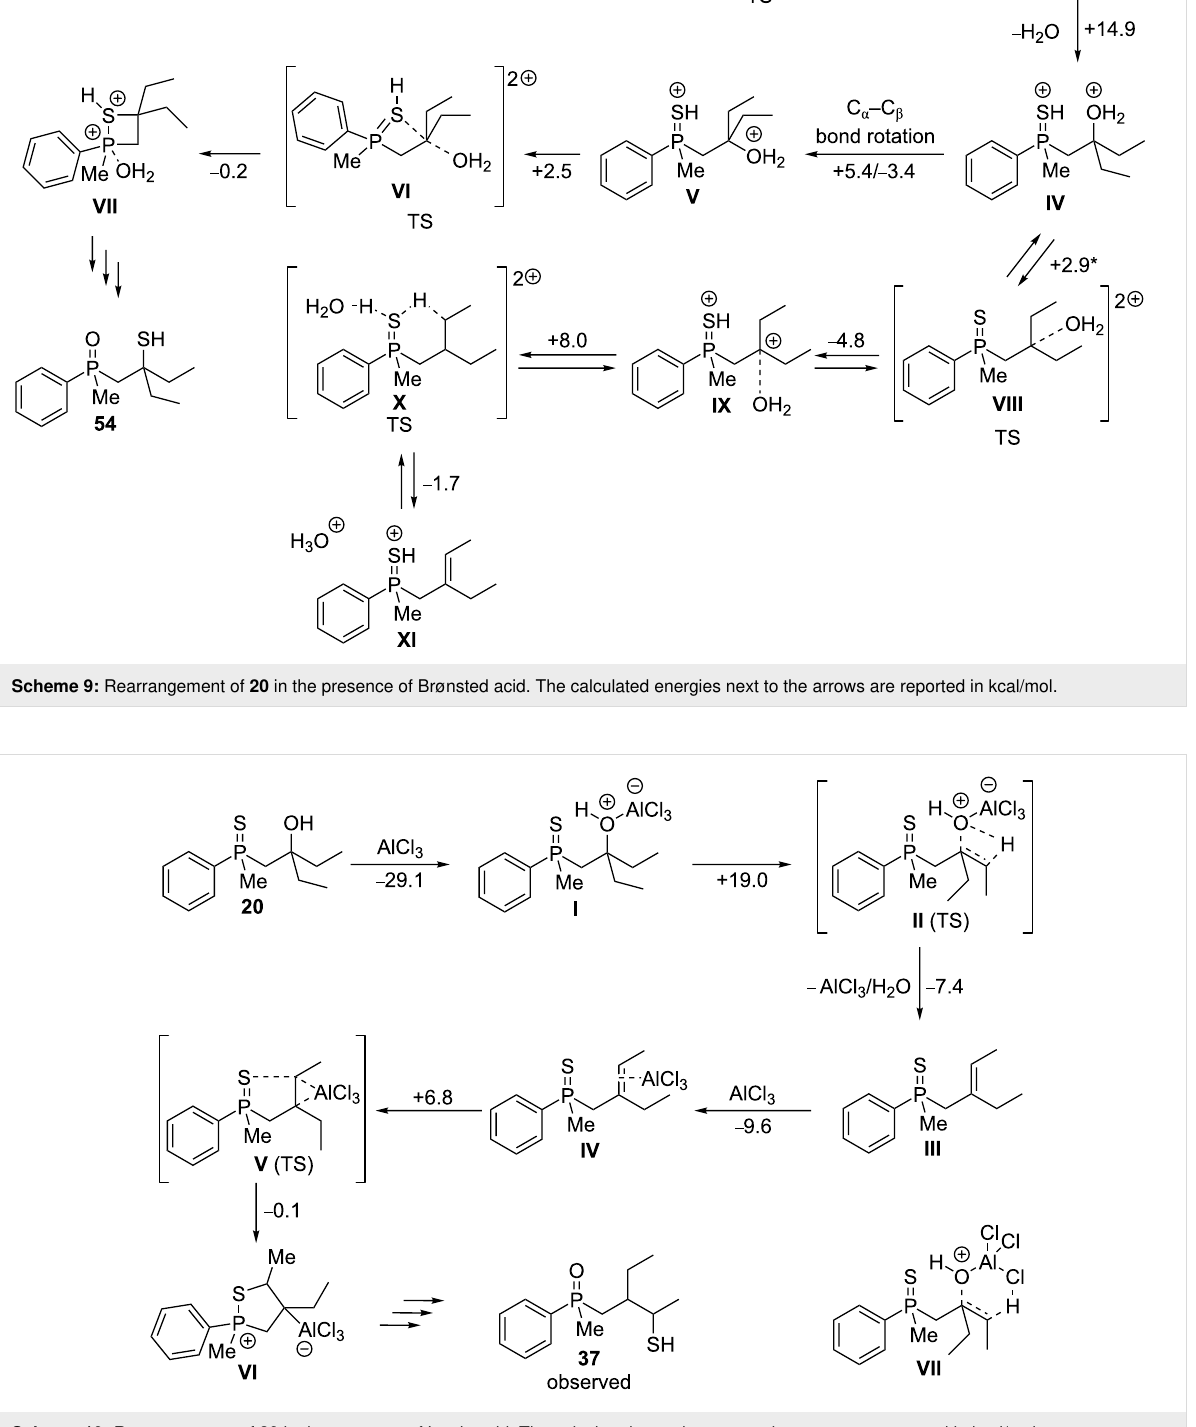
Scheme 10: Rearrangement of 20 in the presence of Lewis acid. The calculated energies next to the arrows are reported in